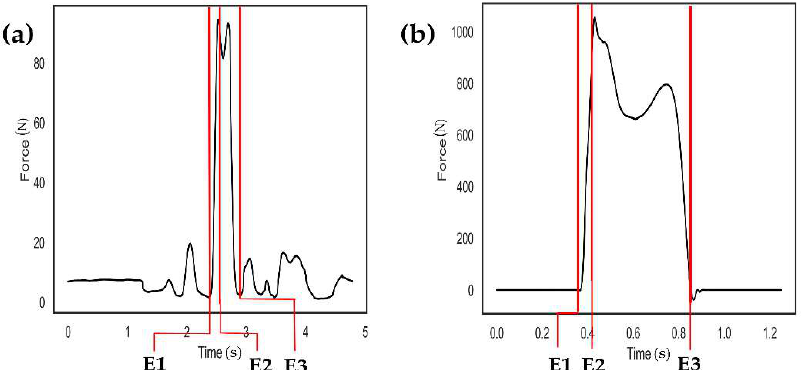
Figure 3. Three events were identified in the force data. ( a ) A representative force curve estimated by pressure sensors (black line) was shown. Event 1 (E1) was defined as the point at which the force value of the pressure sensor continued to increase due to the contact of the participant’s foot with the force plate, while Event 3 (E3) was defined as the time when the pressure value reached the lowest value. Event 2 (E2) was defined as when the pressure value reached the maximum between E1 and E3. ( b ) A representative force curve in the medial-lateral direction measured by the force platform (black line) was shown. Similarly, three events were identified as having been performed for the pressure sensor data.